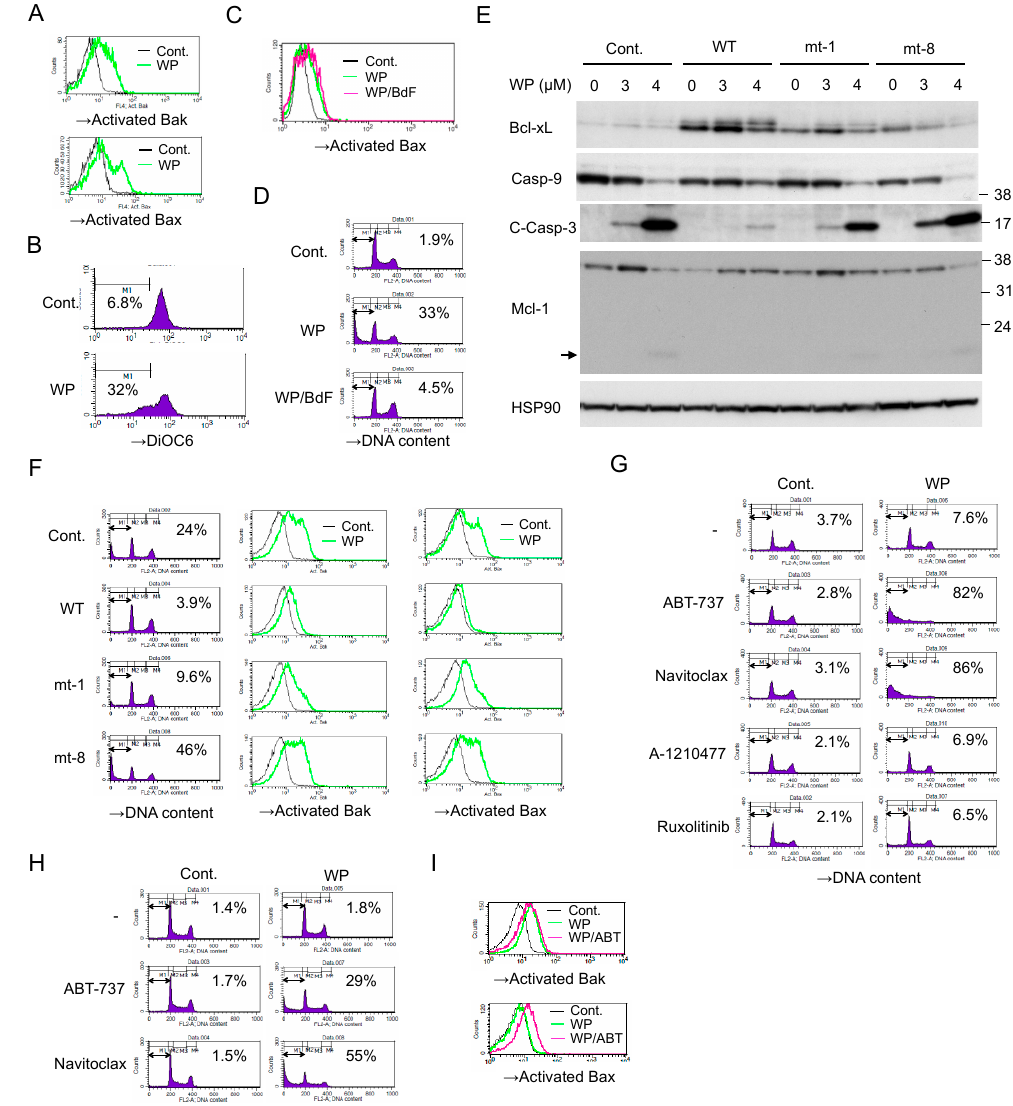
Figure 4. WP1130 induces apoptosis through activation of the intrinsic mitochondria-mediated pathway synergistically with BH3 mimetics. ( A ) HEL cells were left untreated as control (Cont.) or treated with 3 µ M WP1130 (WP) for 20 h. Cells were analyzed for activated Bak and Bax by flow cytometry. ( B ) HEL cells were left untreated as control or treated with 3 µ M WP1130 for 24 h. Cells were analyzed for the mitochondrial membrane potential ( ∆ ϕ m) by flow cytometry using DiOC6. Percentages of cells with reduced ∆ ϕ m are indicated. ( C , D ) HEL cells were left untreated as control or treated for 24 h with 3 µ M WP1130 with or without 100 µ M Boc-d-fmk (BdF), as indicated. Cells were analyzed for activation of Bax ( C ) or DNA content ( D ) by flow cytometry. Percentages of apoptotic cells with the sub-G1 DNA content are indicated. ( E ) HEL cells transduced with wild-type (WT) Bcl-xL or its mutants (mt-1 or mt-8) as well as vector control cells (Cont.) were treated with indicated concentrations of WP1130 for 24 h and subjected to immunoblot analysis. C-Casp-3: cleaved Caspase 3. An arrow indicates the putative degradation product of Mcl-1. ( F ) Cells indicated were treated with 3 µ M WP1130 for 20 h and analyzed. ( G ) HEL cells were left untreated as control or treated for 24 h with 1 µ M ABT-737, 0.5 µ M navitoclax, 10 µ M A-1210477, or 1 µ M ruxolitinib with or without 2 µ M WP1130, as indicated, and analyzed. ( H ) HEL cells were left untreated as control or treated for 6 h with 1 µ M ABT-737 or 1 µ M navitoclax with or without 5 µ M WP1130, as indicated, and analyzed. ( I ) HEL cells were left untreated as control or treated for 6 h with 1 µ M ABT-737 or 3.5 µ M WP1130, as indicated, and